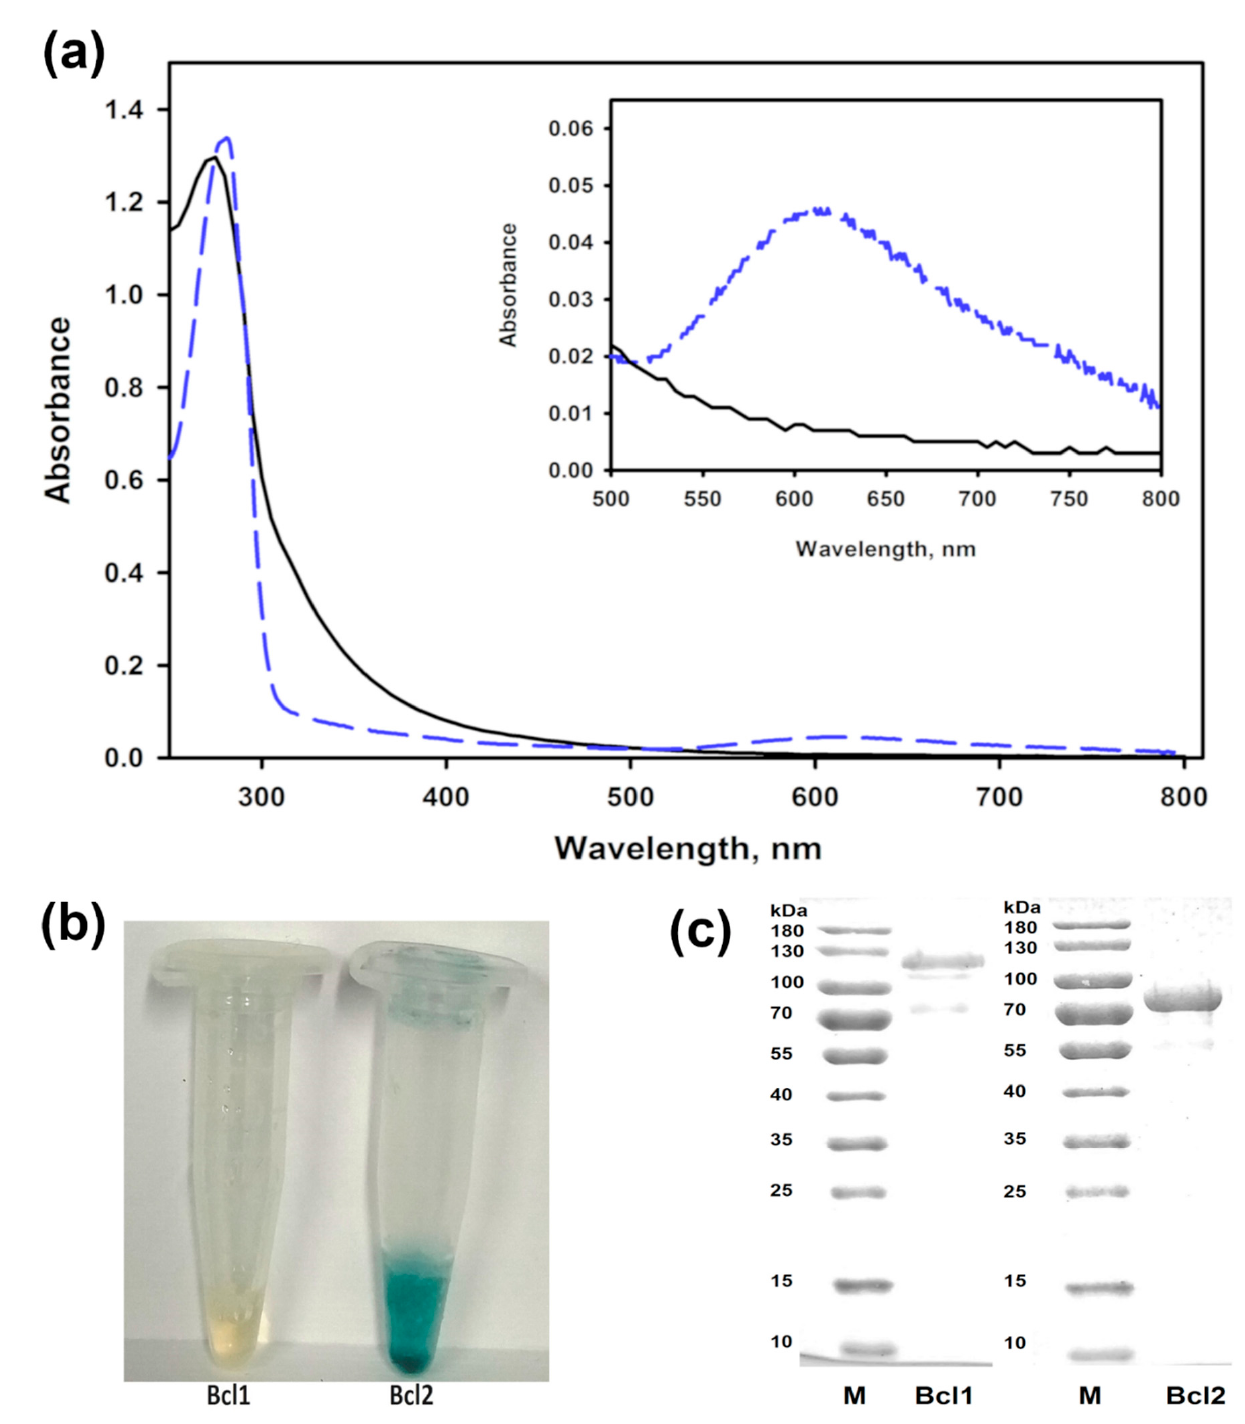
Figure 1. The properties of laccases Bcl1 and Bcl2. ( a ) The UV-VIS spectrum of the purified Botrytis cinerea 241 laccase Bcl1 (black solid line) and Bcl2 (blue dashed line). ( b ) The samples of the purified enzymes. ( c ) SDS-PAGE analysis of the purified proteins. M—molecular mass marker.